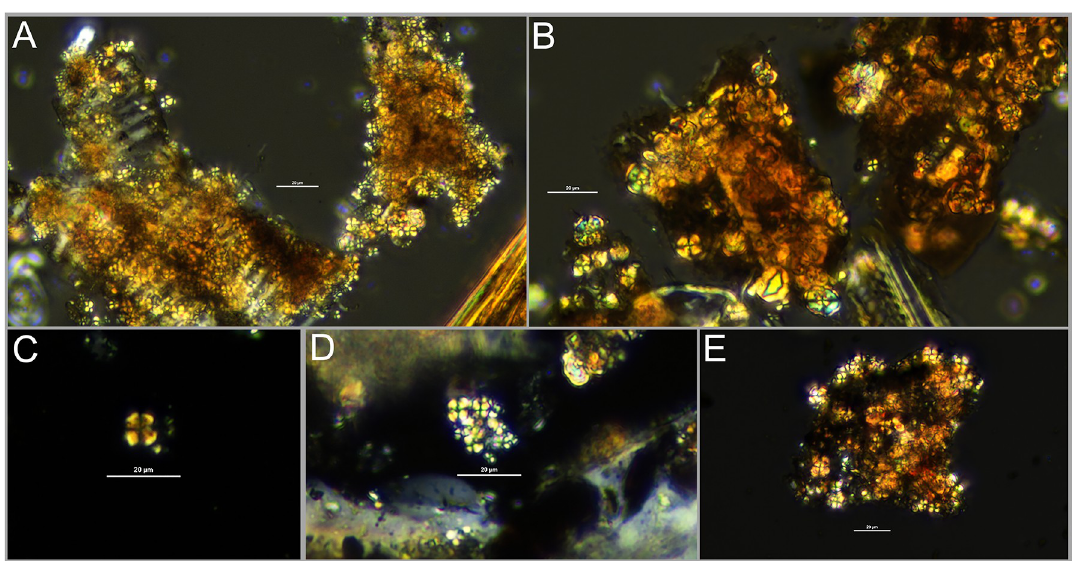
Fig 2. Photographs of spherulites within: A) modern uncharred gazelle ( Gazella gazella) dung; B) modern uncharred goat ( Capra aegagrus hircus) dung with organic “fibers”; and examples of C) an isolated individual spherulite; D) a 2-dimensional cluster of spherulites; and E) a 3-dimensional spherulite cluster. Scale bar in all images = 20 μ